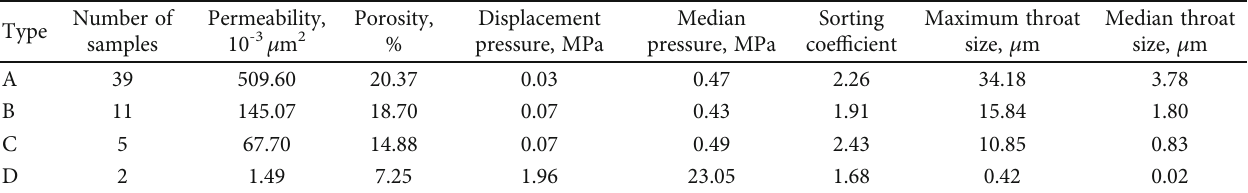
Figure 9: Typical mercury intrusion curve of Yingmai 7 block. Table 4: Statistics of the average pore structure characteristic parameters of block Yingmai